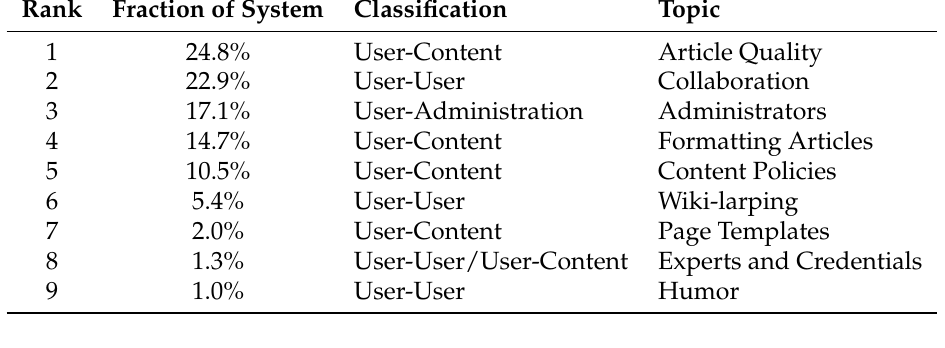
Table 2. Top nine Louvain clusters, by number of nodes. Communities fall into three classifications (user-user, user-content, user-administration), based on the interactions they govern; we determine these labels by inspecting the top ten nodes by centrality within each cluster.